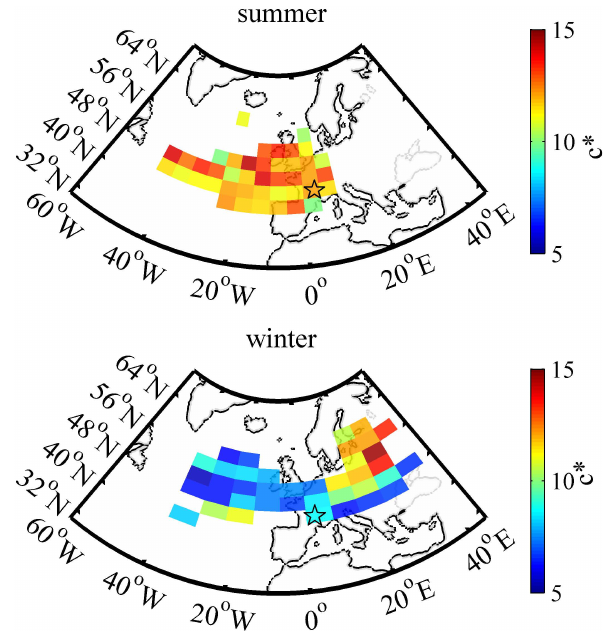
Fig. 9. Aerosol organic mass fraction from AMS with the air mass origin during summer (up) and winter (down) for the periods of simultanious CCN measurements. The star marks the location of the measurement site. For details of the calculations, see Sect. 3.3: aerosol CCN properties by air masses.